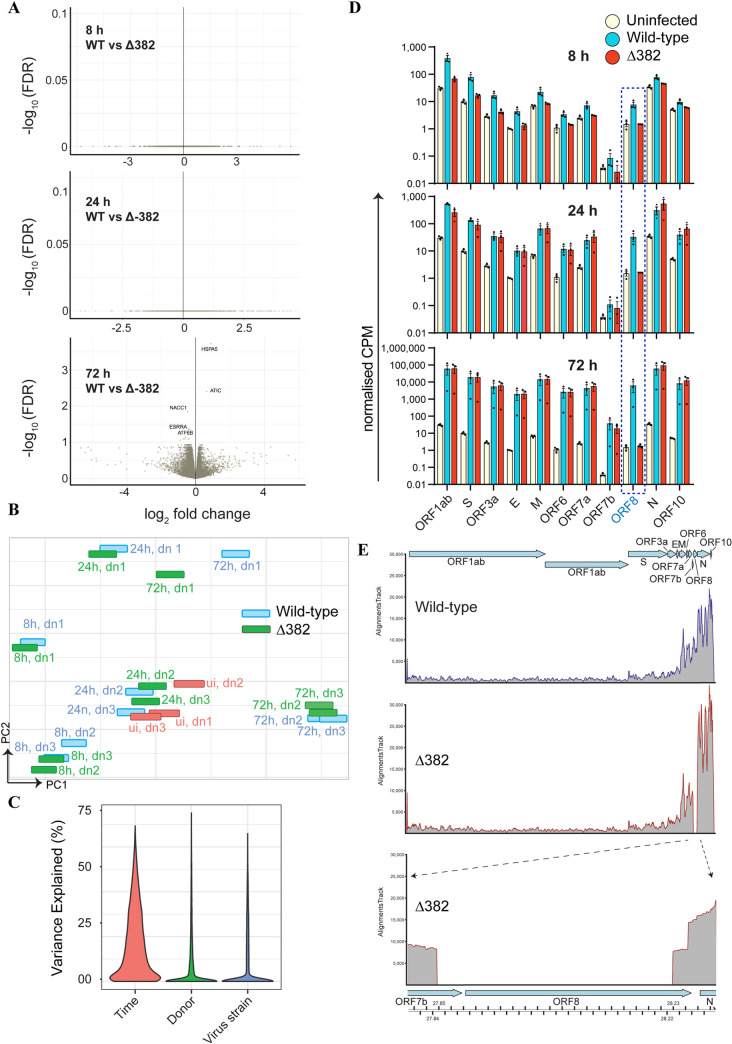
Similar gene expression profile upon NEC infection with SARS-CoV-2 and Δ382 (A) Volcano plot of DEGs at 8 h, 24 h and 72 h after infection of NECs with wild-type SARS-CoV-2 vs Δ382. Statistically significant DEGs (adjusted p-value < 0.05) are annotated. None of the DEGs have an adjusted p-value < 0.05 and log FC of at least 1.5. (B) PCA plot of transcriptomes from uninfected (ui), wild-type or Δ382 infected donor (dn)-derived NECs, according to gene-expression profiles (C) Percentage of variance explained by post-infection time-point, donor and virus strain for each expressed gene within the transcriptome dataset. (D) Normalized CPM values for SARS-CoV-2 genes detected at each of the indicated time-points from wild-type and Δ382 infected NECs (E) Coverage plot of viral transcripts from wild-type and Δ382 infected NECs at 72 hpi overlaid with the SARS-CoV-2 genome (top inset). Lower panel displays genomic region deleted in Δ382 for which transcript mapping is absent. Each tick represents 10bp on the SARS-CoV-2 genome. All coverage plots are representative images of merged coverage of all three biological replicates, sampled at 1% depth each.